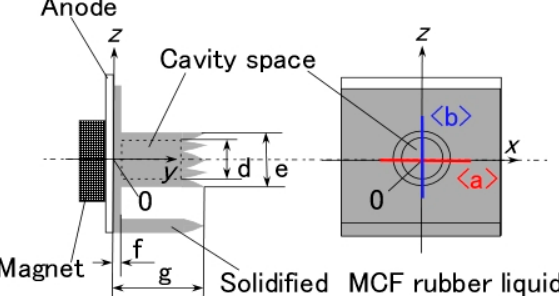
Figure 3. Schematic diagram of MCF rubber liquid solidified using the NM. The position for measuring magnetic field distributions shown in Figure 5 is also delineated.